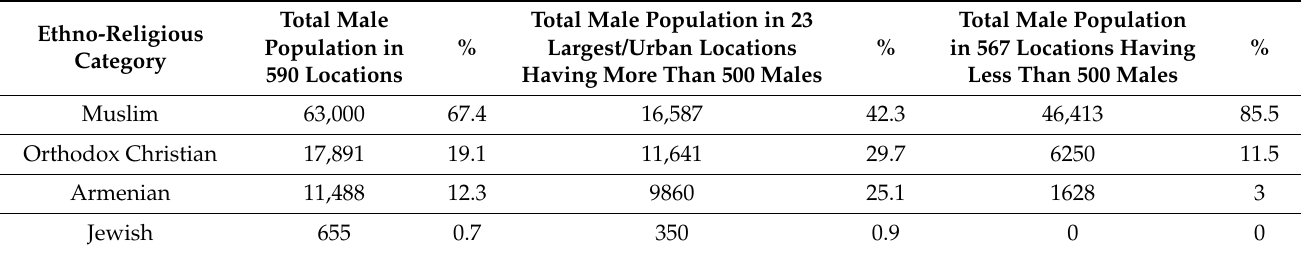
Table 1. Ethno-religious breakdown of male population in registered categories 1